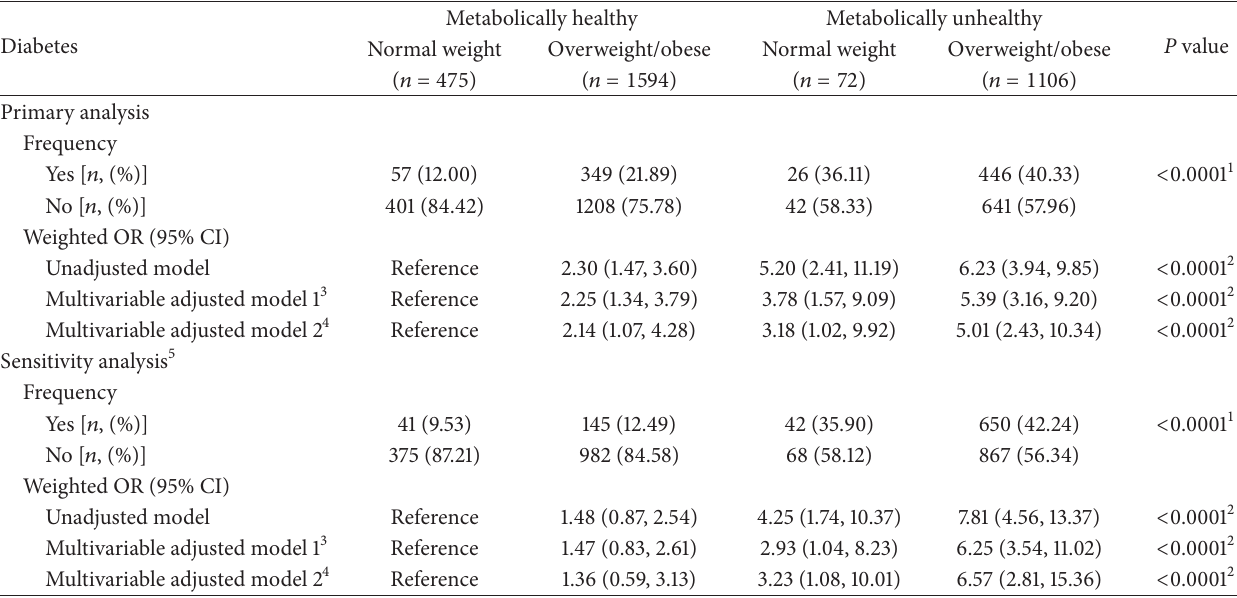
Table 2: Diabetes by overweight/obese type and metabolic health status.